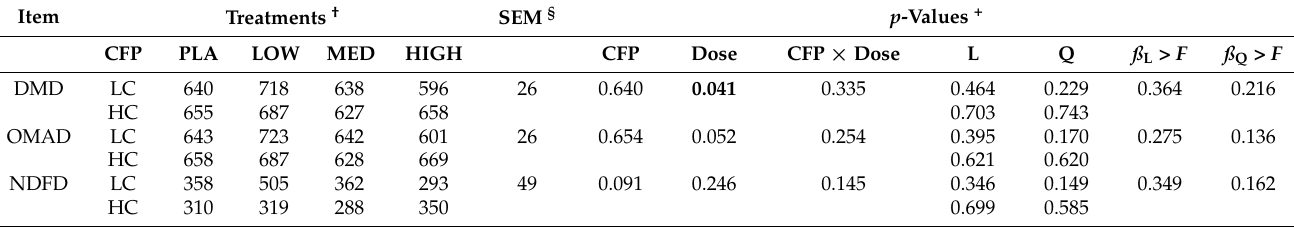
† Values presented as LS means. § SEM, standard error of the means. + Effects of CFP, 3-NOP dose, and interactions between them; L, Q, p -values for linear and quadratic effects of 3-NOP; ß L > F , ß Q > F , probability under H 0 that an F-distributed random variable exceeds observed F , for the difference in the linear and quadratic regression coefficients between LC and HC. Significant values ( p ≤ 0.05 are highlighted in